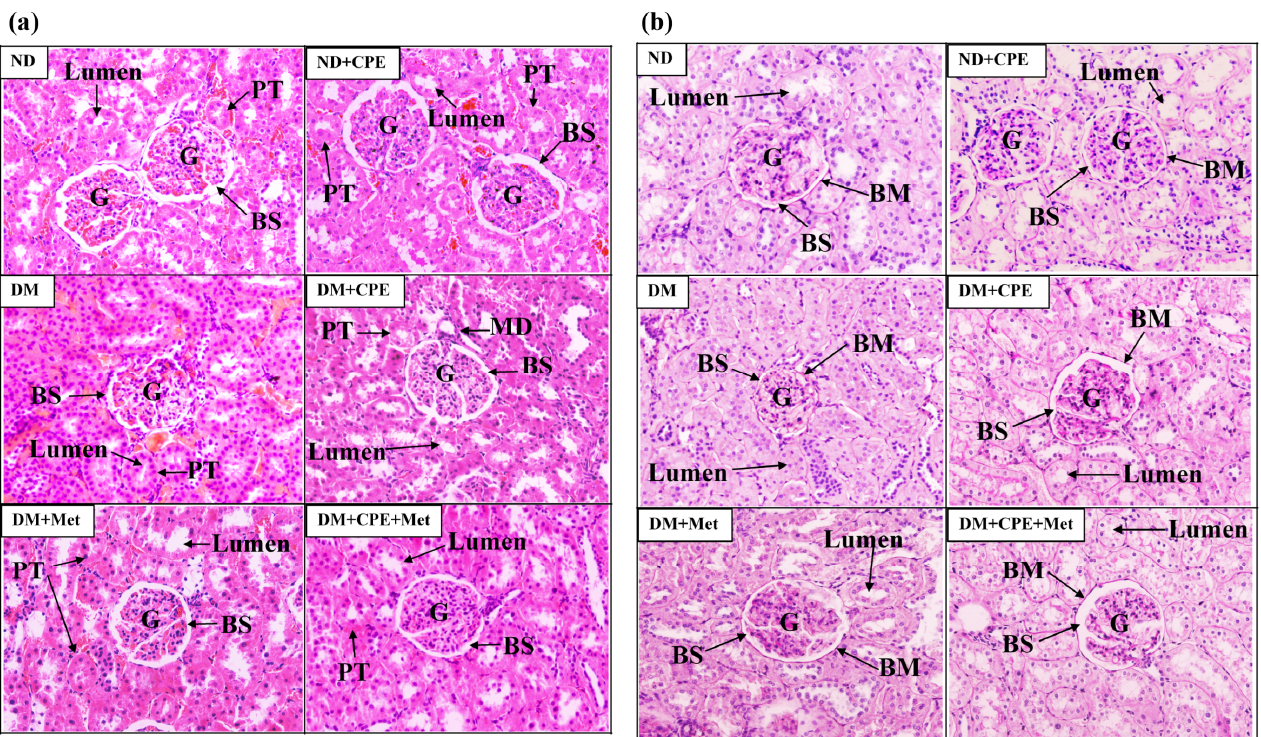
Figure 1. Effect of CPE on renal histopathological photomicrograph in T2D rats stained by ( a ) hematoxylin and eosin and ( b ) periodic acid-Schiff base at 200 × X. The data were taken from 5–6 different animals and analyzed using bright-field microscopy. Arrow “BS” indicates the Bowman’s capsule space; “LS” indicates the tubular lumen space; “PT” indicates the proximal tubular epithelial cells and proximal convoluted tubule; “MD” indicates the macular densa; and “BM” indicates the basement membrane. Abbreviation: glomerulus (G).